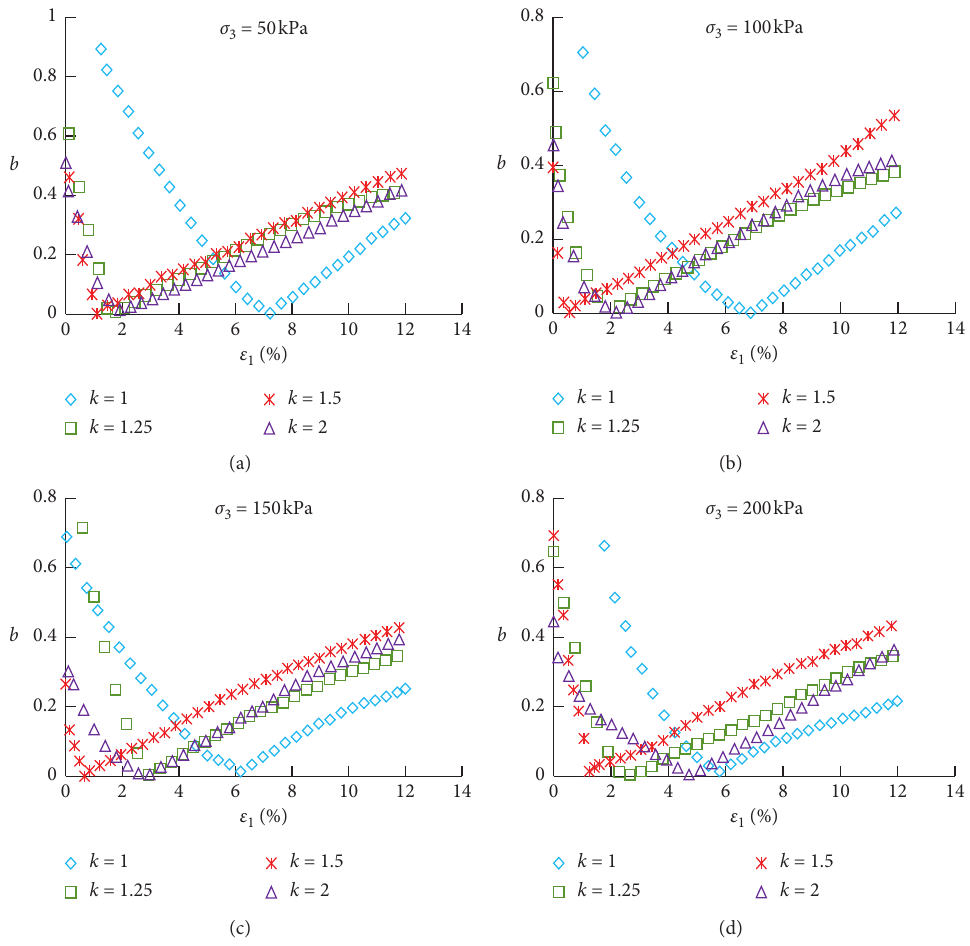
Figure 10: b ∼ ε curves of intact loess at different k 1